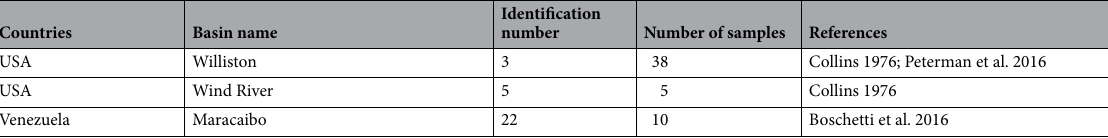
Table 1. Published sources used for building the database. The identification number refers to Fig. 1. References are listed in the Supplementary references section.